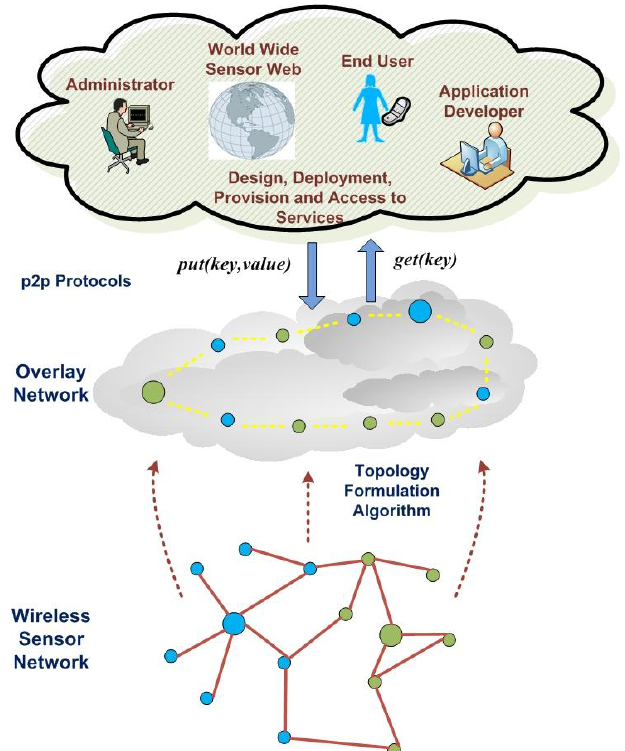
Figure 8. Autonomic Provision of